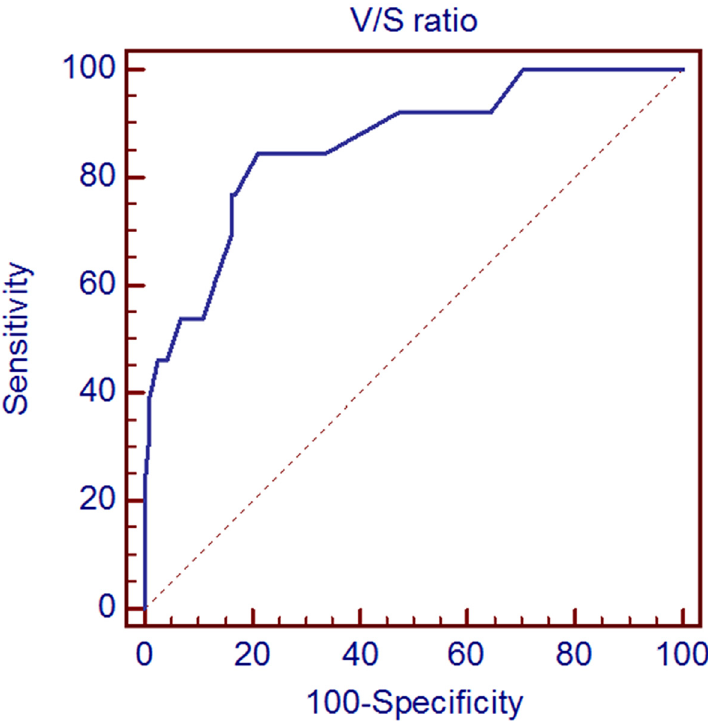
Fig 2. Receiver operating characteristic (ROC) analysis of maximum standardized uptake value of visceral fat/ maximum standardized uptake value of subcutaneous fat (V/S) ratio in colorectal cancer patients for the prediction of distant